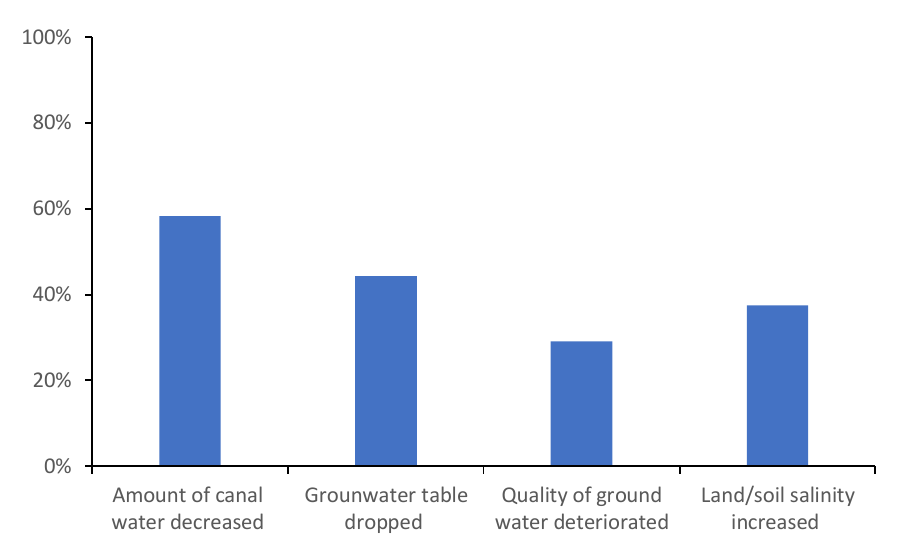
Figure 2. Response of the farmers to environmental changes in the Mungi area.